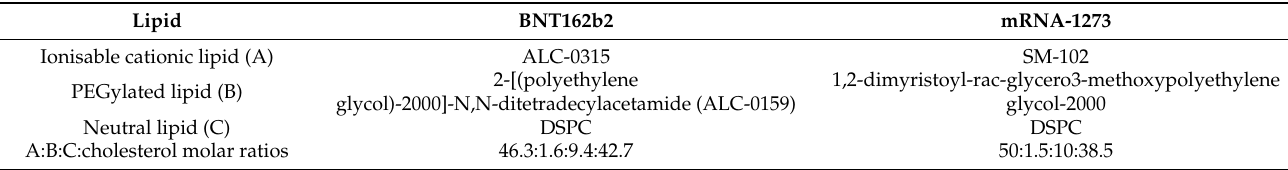
Table 2. Lipid composition of BNT162b2 and mRNA-1273